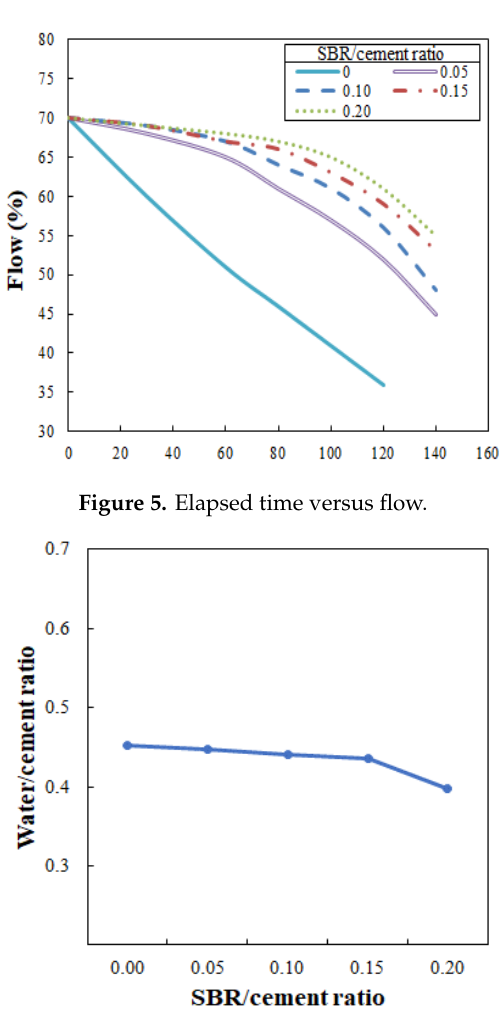
Figure 6. Water / cement ratios required to determine the optimal flow of Figure 6. Water/cement ratios required to determine the optimal flow of 70%. Figure 6. Water/cement ratios required to determine the optimal flow of 70%.